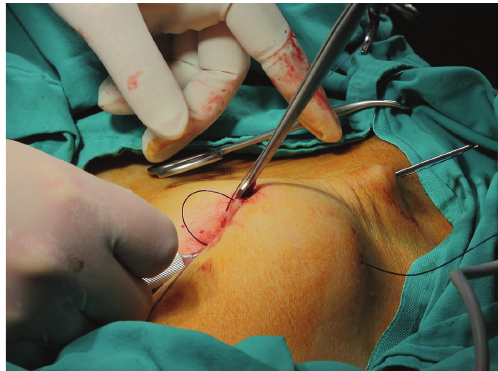
Figure 3: Transabdominal passage of the Veress cannula loaded with a nylon suture.